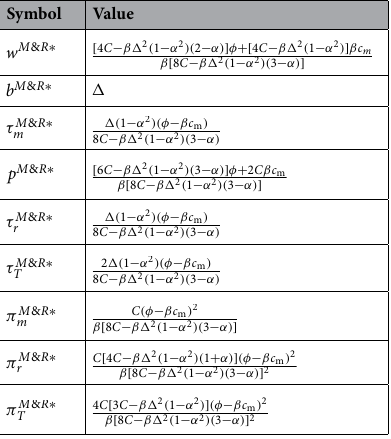
Table 2. The optimal decisions in the M&R